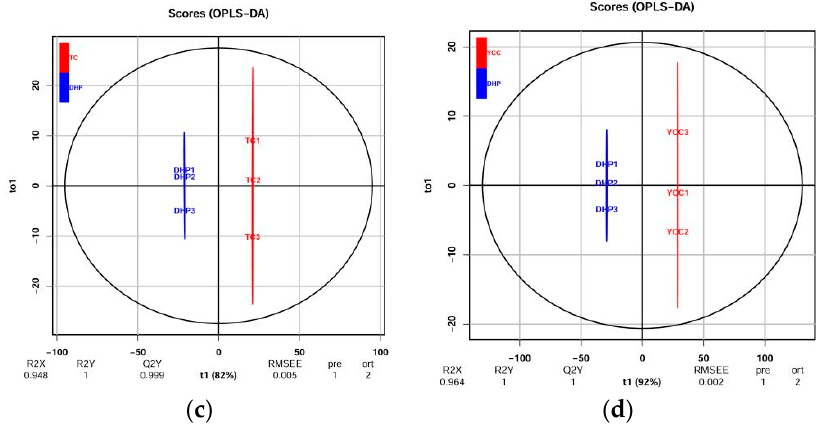
Figure 3. Differential flavonoid metabolite analysis on the basis of orthogonal signal correction and partial least squares-discriminant analysis (OPLS-DA). ( a – d ) OPLS-DA model plots for the comparison group DHP versus BZH, DHP versus HZY, DHP versus TC, DHP versus YCC, respectively.